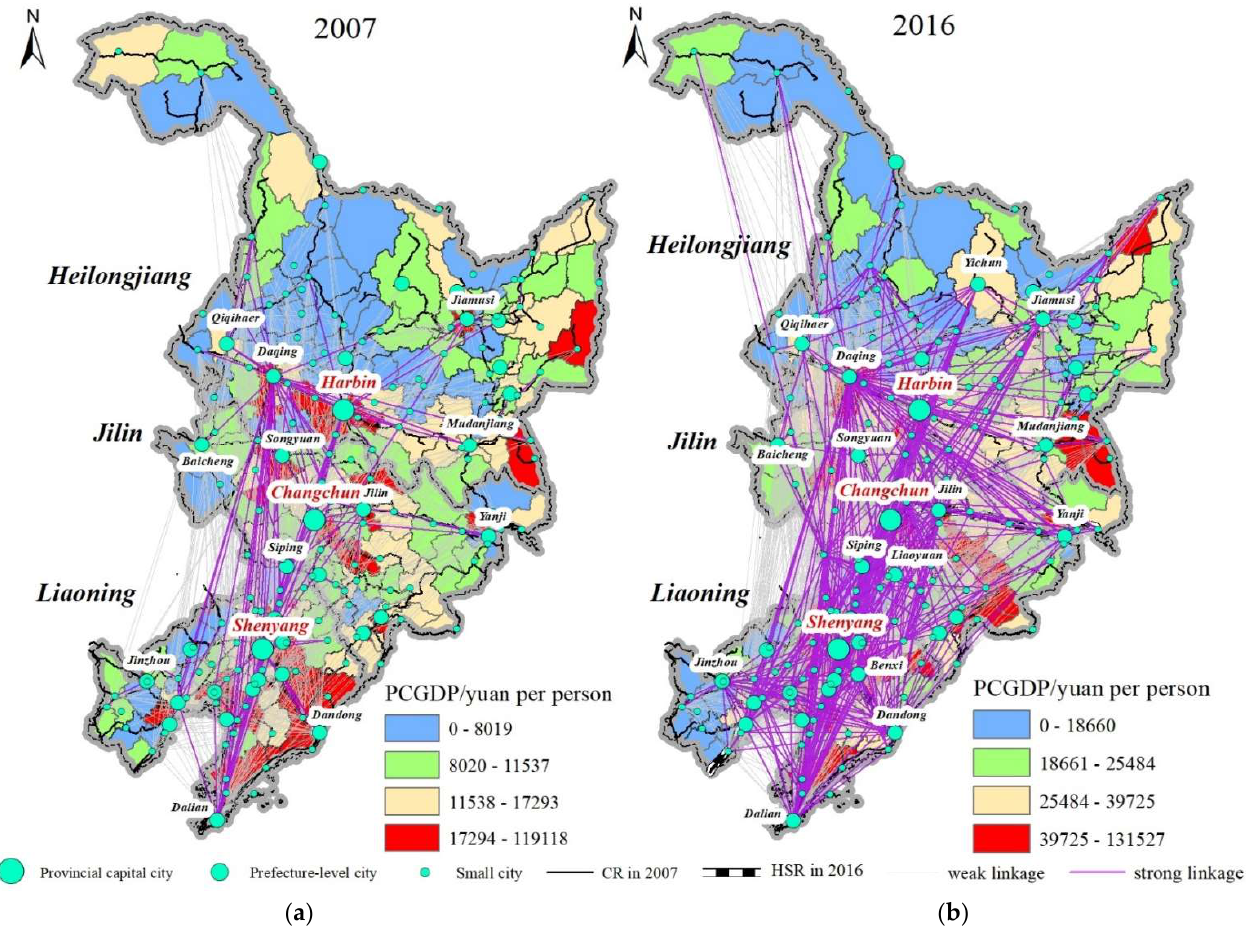
Figure 3. The dynamics of economic linkages before and after HSR (( a ) represents economic linkages before HSR in 2007 whereas ( b ) denotes economic linkages after HSR in 2016; economic linkages are categorized as strong linkages and weak linkages; if the value of an economic linkage from the source city to the destination is larger than the average value of all economic linkages, then the line is categorized as a strong linkage, otherwise a weak